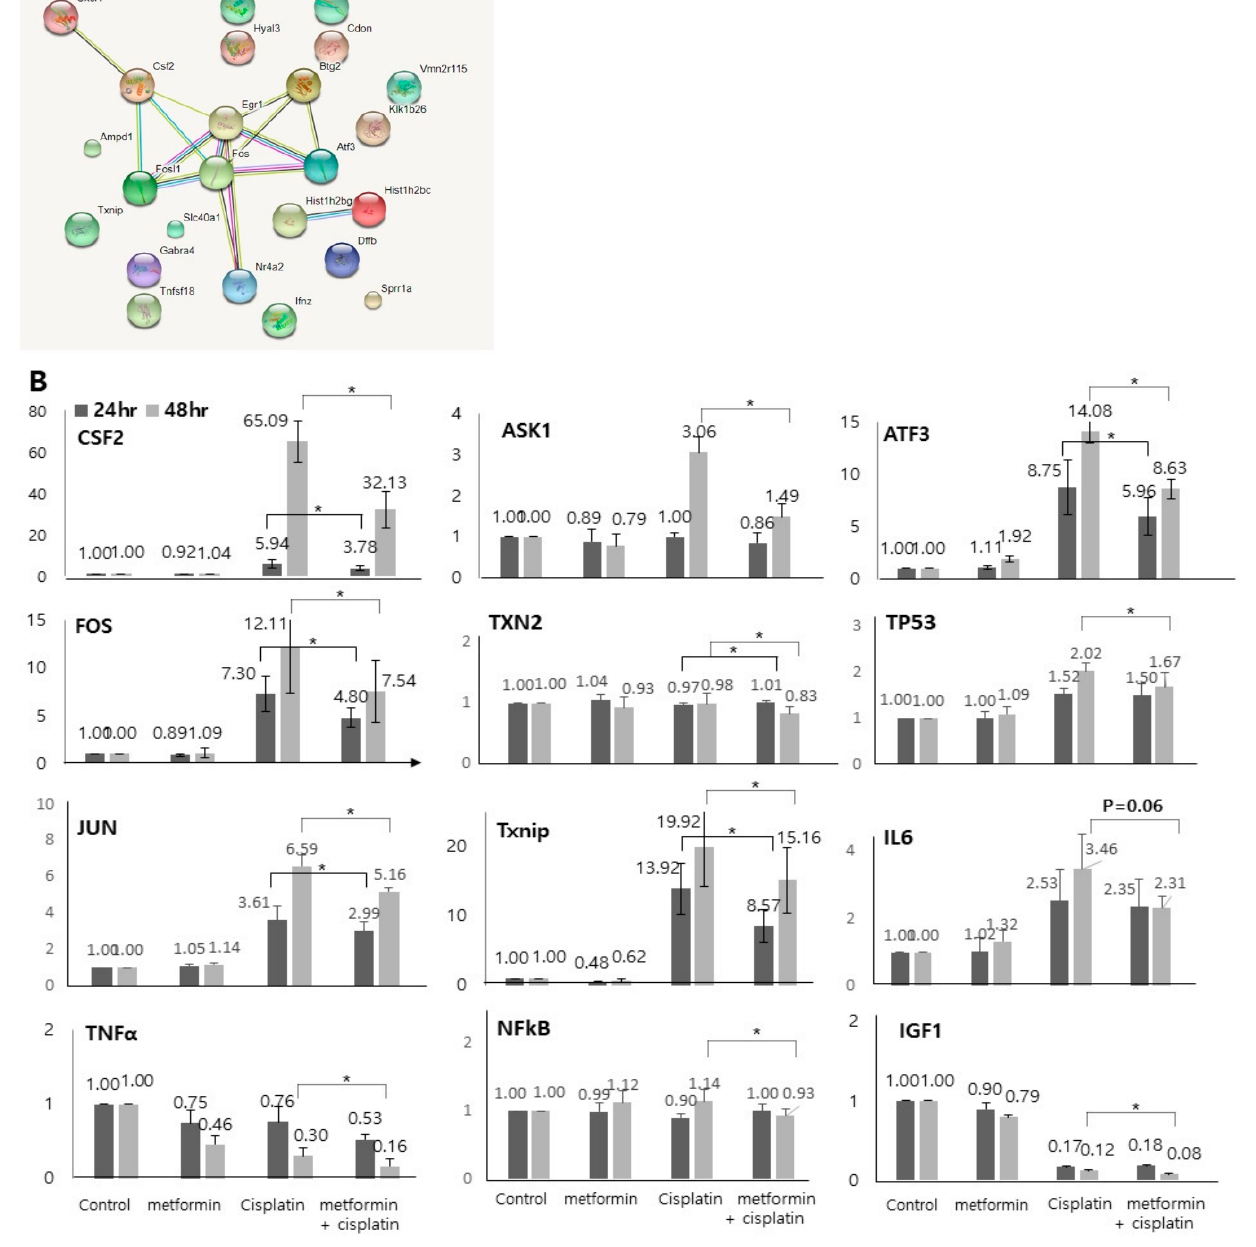
Figure 5. Network analysis and qRT-PCR expression levels of the potential biomarkers. ( A ). The network analysis was performed among genes that were significantly expressed oppositely in re- sponse to cisplatin and the application of metformin (48 cisplatin group vs. 48 h metformin-pre- treated group). Various genes such as Fos, Fosl1, Csf2, Cxcl1, Egr1, Btg2, Atf3, and Nr4a2 were iden- tified to be related to each other. ( B ) 48 h cisplatin exposure-induced and metformin-pretreated prior to 48 h cisplatin exposure-induced genes validated by qRT-PCR. In accordance with the microarray results, the expression levels of CSF2, FOS, JUN, TNF α , NF κ B, Txnip, ASK1, TXN2, ATF3, TP53, and IGF were found to be decreased after application of metformin ( p < 0.05). The expression levels of IL6 decreased after application of metformin but it was not statistically significant ( p = 0.06). Solid